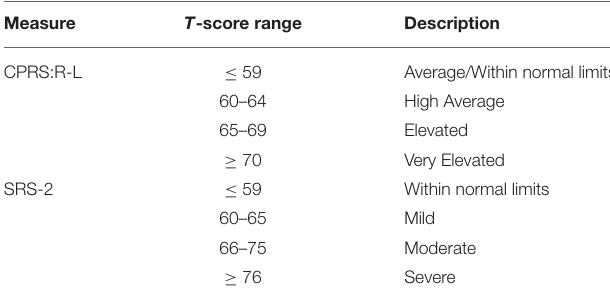
TABLE 1 | CPRS:R-L and SRS-2 Severity